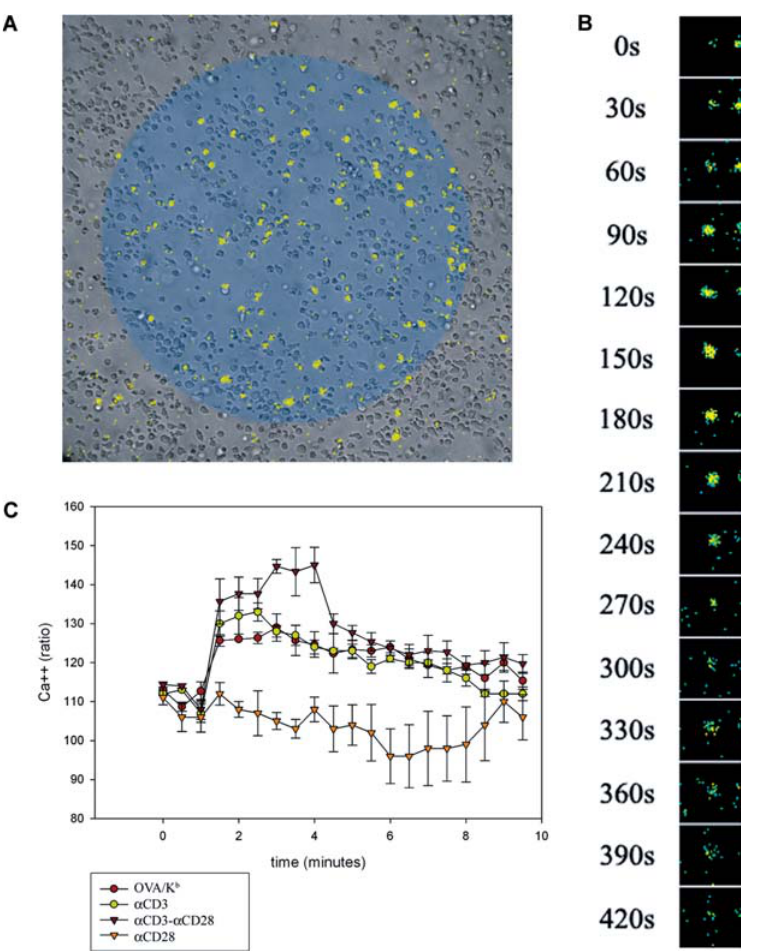
Figure 5. Activation of OT-1 Lymphocytes Following an Exposure to Preprinted Spots on an MHC Array OT-1 lymphocytes were preloaded with Fura-2 dye for 20 min at room temper- ature prior to exposure to the cellular microarray (time 0). The cells were incubated at 37 8 C, 5% CO 2 , and fluo- rescence intensities at 340 nm and 380 nm were measured every 30 s from each of the spots on the array. Calcium flux signal was triggered in the OVA-specific cells as soon as they reached the OVA/K b tetramer spots, the activating antibody spots (anti-CD3 and anti-CD3/anti- CD28), but not the irrelevant MCC/E k tetramer or the nonactivating antibody spots (e.g. anti-CD28). (A) Calcium flux signal (yellow) overlaid onto a 10x DIC image of OT-1 cells on a combined FITC-labeled anti-CD3/anti- CD28 spot. Fura-2 fluorescence intensity ratios are represented in pseudo-color, and the overlaid spot region (blue) is determined from the FITC image. Note that the spot pattern can be inferred from the Fura-2 signal representing activation, even without removing un- bound cells. (B) A time-lapsed series of images taken of a representative OT-1 lymphocyte specifically immobilized onto an OVA/ K b spot. The cell undergoes a rapid, transient calcium flux as measured by Fura-2 fluorescence. (C) Averaged calcium flux traces ( n ¼ 3) recorded from an OVA/K b spot (purple circles), anti-CD3/anti-CD28 spot (brown triangles), anti-CD3 spot (green circles), and nonactivating anti-CD28 spot (or- ange triangles). Error bars represent calculated standard error of mean. DOI: